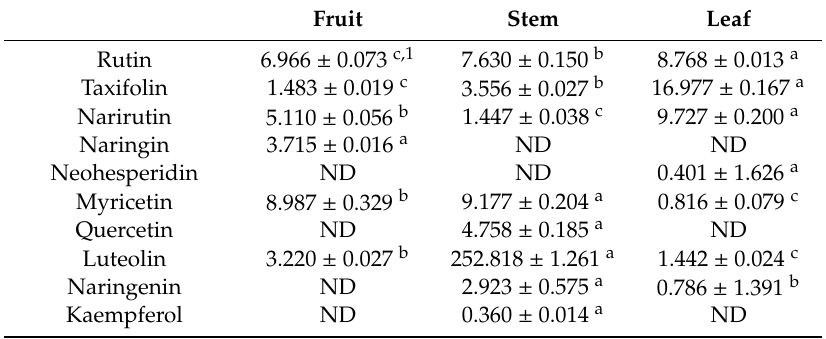
Table 1. Polyphenolic compounds in Abeliophyllum distichum organ extracts.